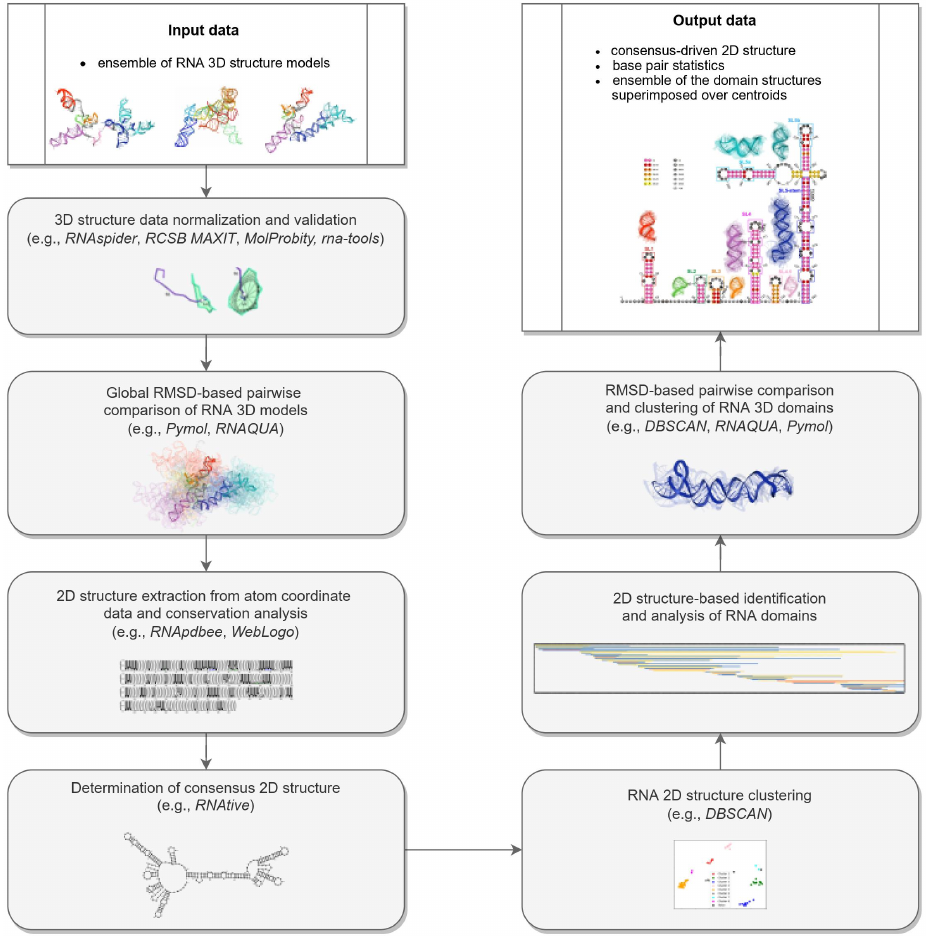
Figure 10. The workflow of the reference-free comparative analysis of RNA 3D